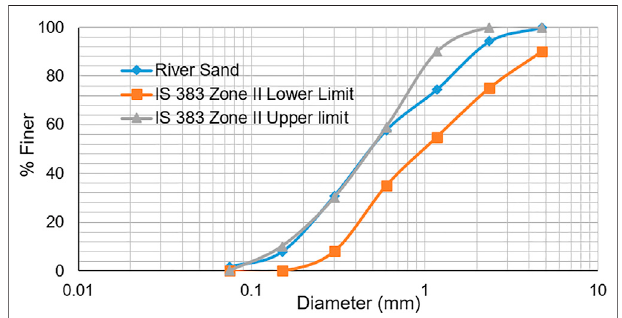
FIGURE 1 | Particle size distribution curve of fi ne